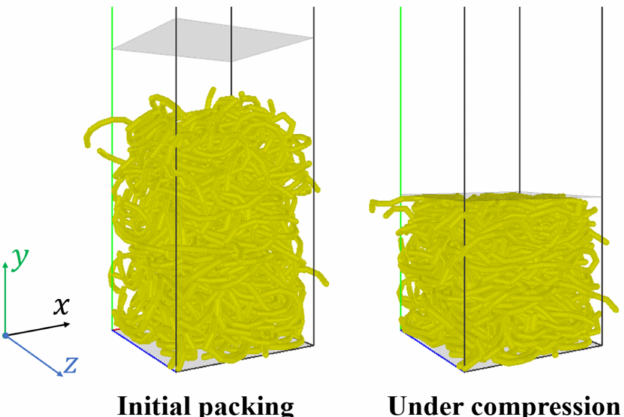
Figure 6. Numerical model of uniaxial compression of S-shaped fibers. The pressure P —solid volume fraction φ curves for the first three load–unload cycles of the straight fibers with κ = 0 m − 1 and S-shaped fibers with κ = 100 m − 1 are shown in Figure 7. The load–unload cycle 2 shifts to the right-hand side after the cycle 1 due to the fiber rearrangement and the consolidation of the fiber bed after the first load–unload cycle. The P − φ loop of the load-unload cycle 3 is very close to that of the cycle 2. At a given solid volume fraction φ , a larger pressure P is observed for the S-shaped fibers compared to the straight fibers, and a sharper increase in P with φ is obtained for the S-shaped